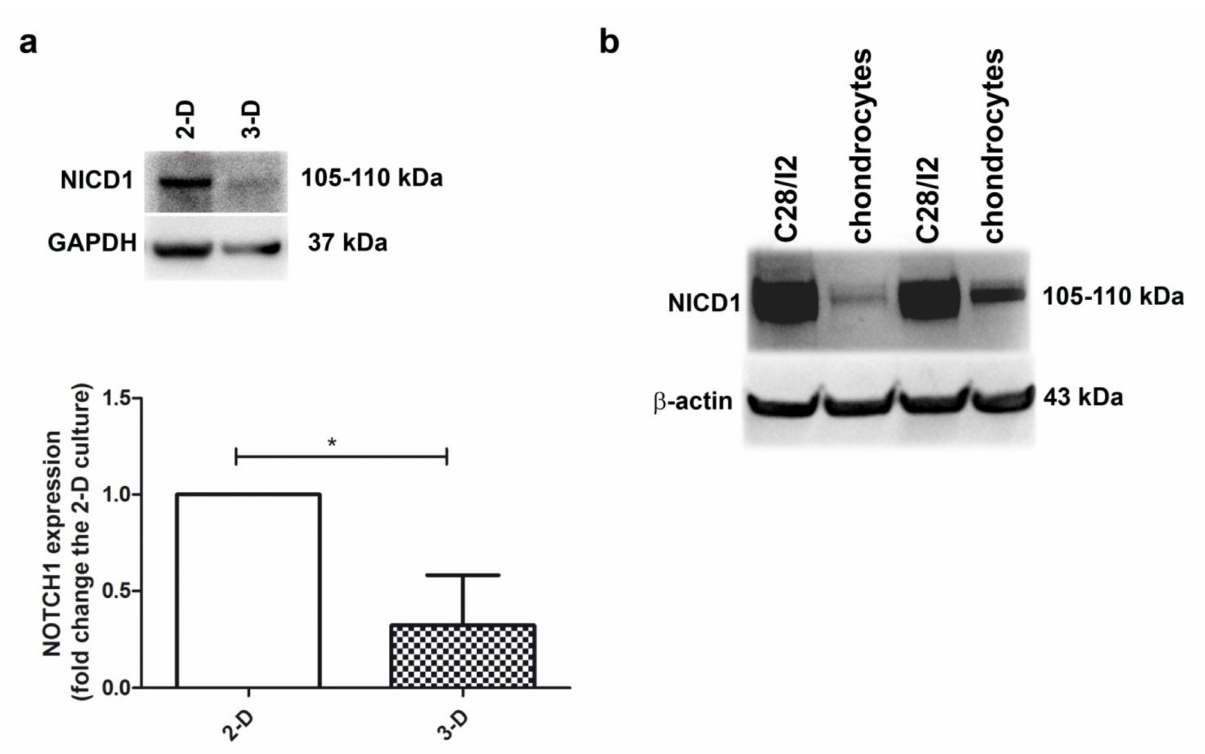
Figure 1. Higher NOTCH1 expression is evident in proliferating chondrocyte cultures. ( a ) To assess NOTCH1 expression and modulation in human chondrocyte cultures, the active form of the receptor was evaluated in monolayer culture and in micromasses at 1 week maturation. GAPDH was used as a loading control. A representative example and a cumulative evaluation performed with samples from three different patients. * p < 0.05. ( b ) Western blot analysis of NOTCH1 expression in C28/I2 cells compared to primary chondrocytes, with β -actin as a loading